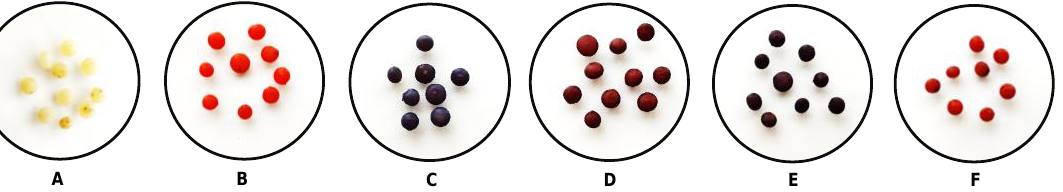
Figure 2. Images of CSCH beads before dye adsorption ( A ) and after adsorption of AR ( B ), RB ( C ), 25% AR + 75% RB ( D ), 50% AR + 50% RB ( E ), and 75% AR + 25% RB ( F ).